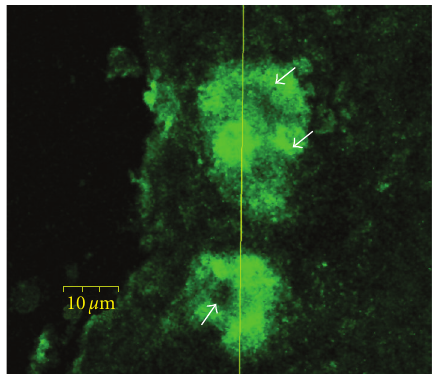
Figure 5: Distribution of immunoreactive MBP domain within human airway following overnight incubation with human eosinophils. MBP (green) is shown as focal deposits. Arrows indicate eosinophil “ghosts” (confocal microscopy 600x).